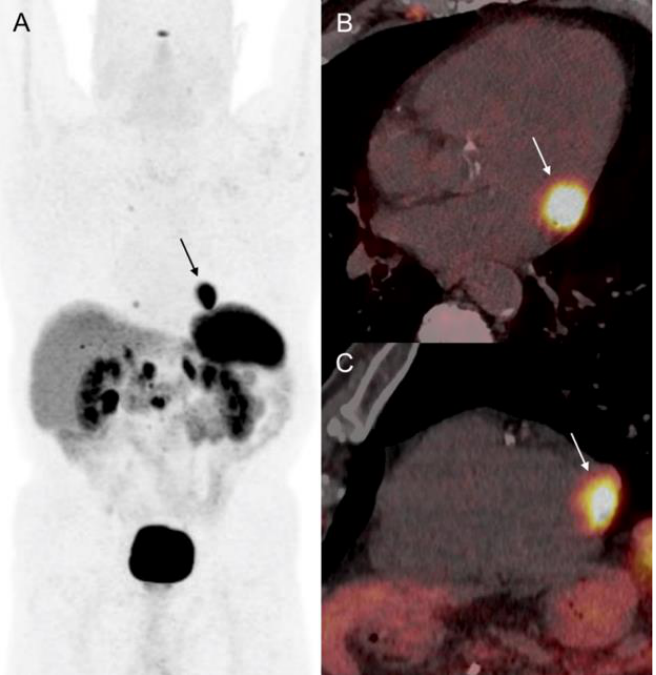
Figure 4. Patient 2. 74-year-old patient with metastatic si-NET and LV CM (arrows) showing intense uptake of 68 Ga-DOTATOC (( A ) MIP anterior projection, ( B ) PET/CT horizontal long axis, and ( C ) PET/CT short axis).